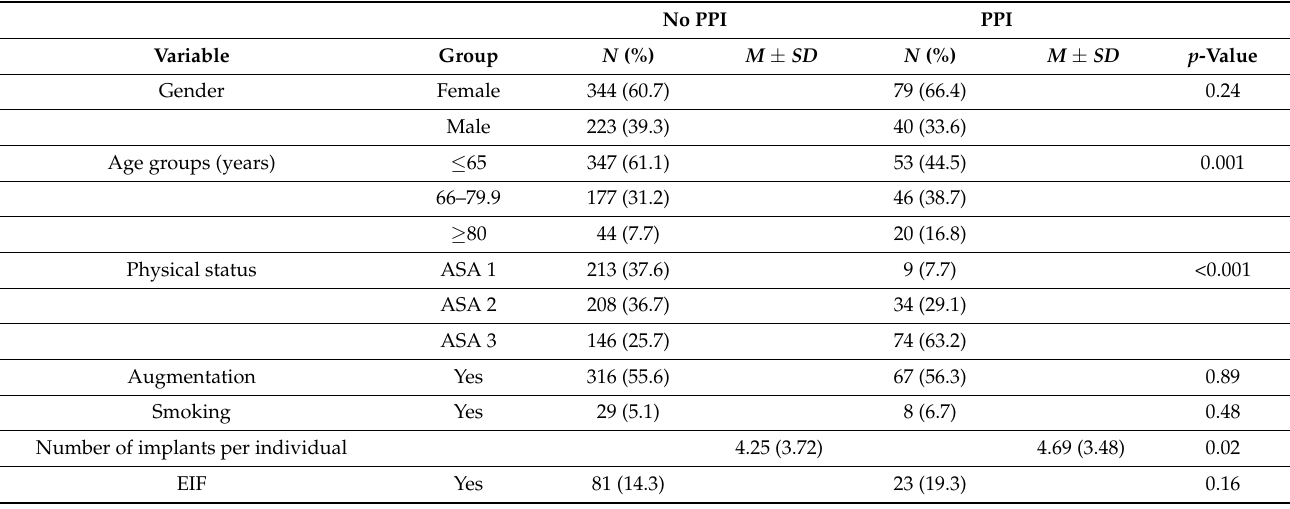
Table 2. Univariate tests at the patient